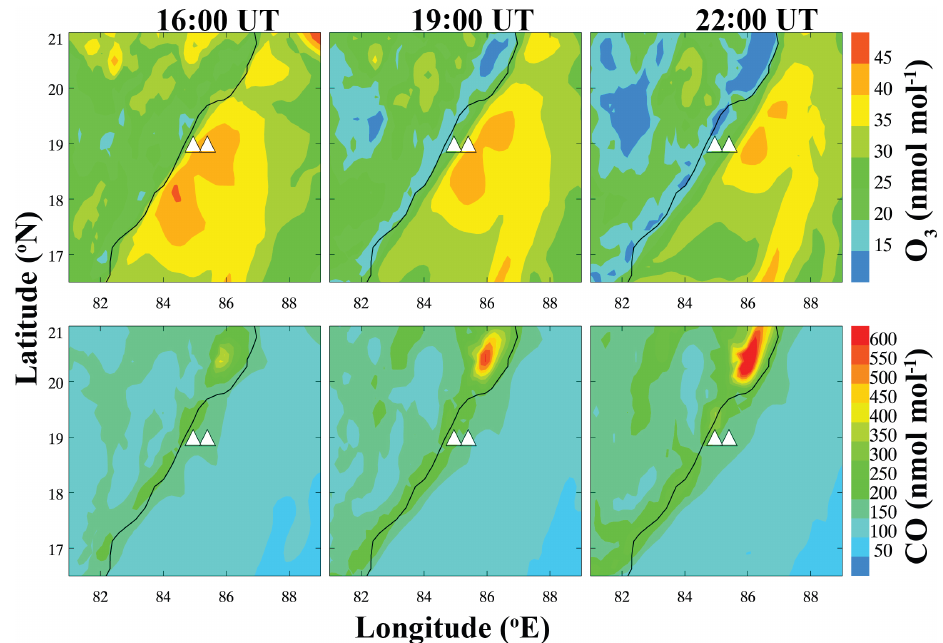
Figure 11. Spatial distribution of surface O 3 (top panel) and CO (bottom panel) at 16:00 and 19:00 UT on 10 August 2009, both prior to and during the fourth event, which took place 22:00 UT on 10 August 2009. White triangles show two locations (85.40 ◦ E, 19.00 ◦ N; 84.95 ◦ E, 19.00 ◦ N) corresponding to the